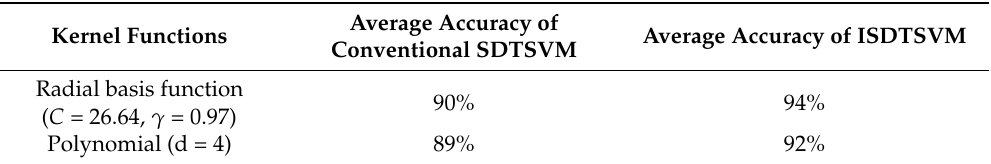
Figure 17. The tree structure obtained by the ISDTSVM algorithm. Table 4. Classification results of the steel cord conveyor belt defects signals using the ISDTSVM and the conventional SDTSVM algorithm with different kernel functions and five-fold cross-validation.